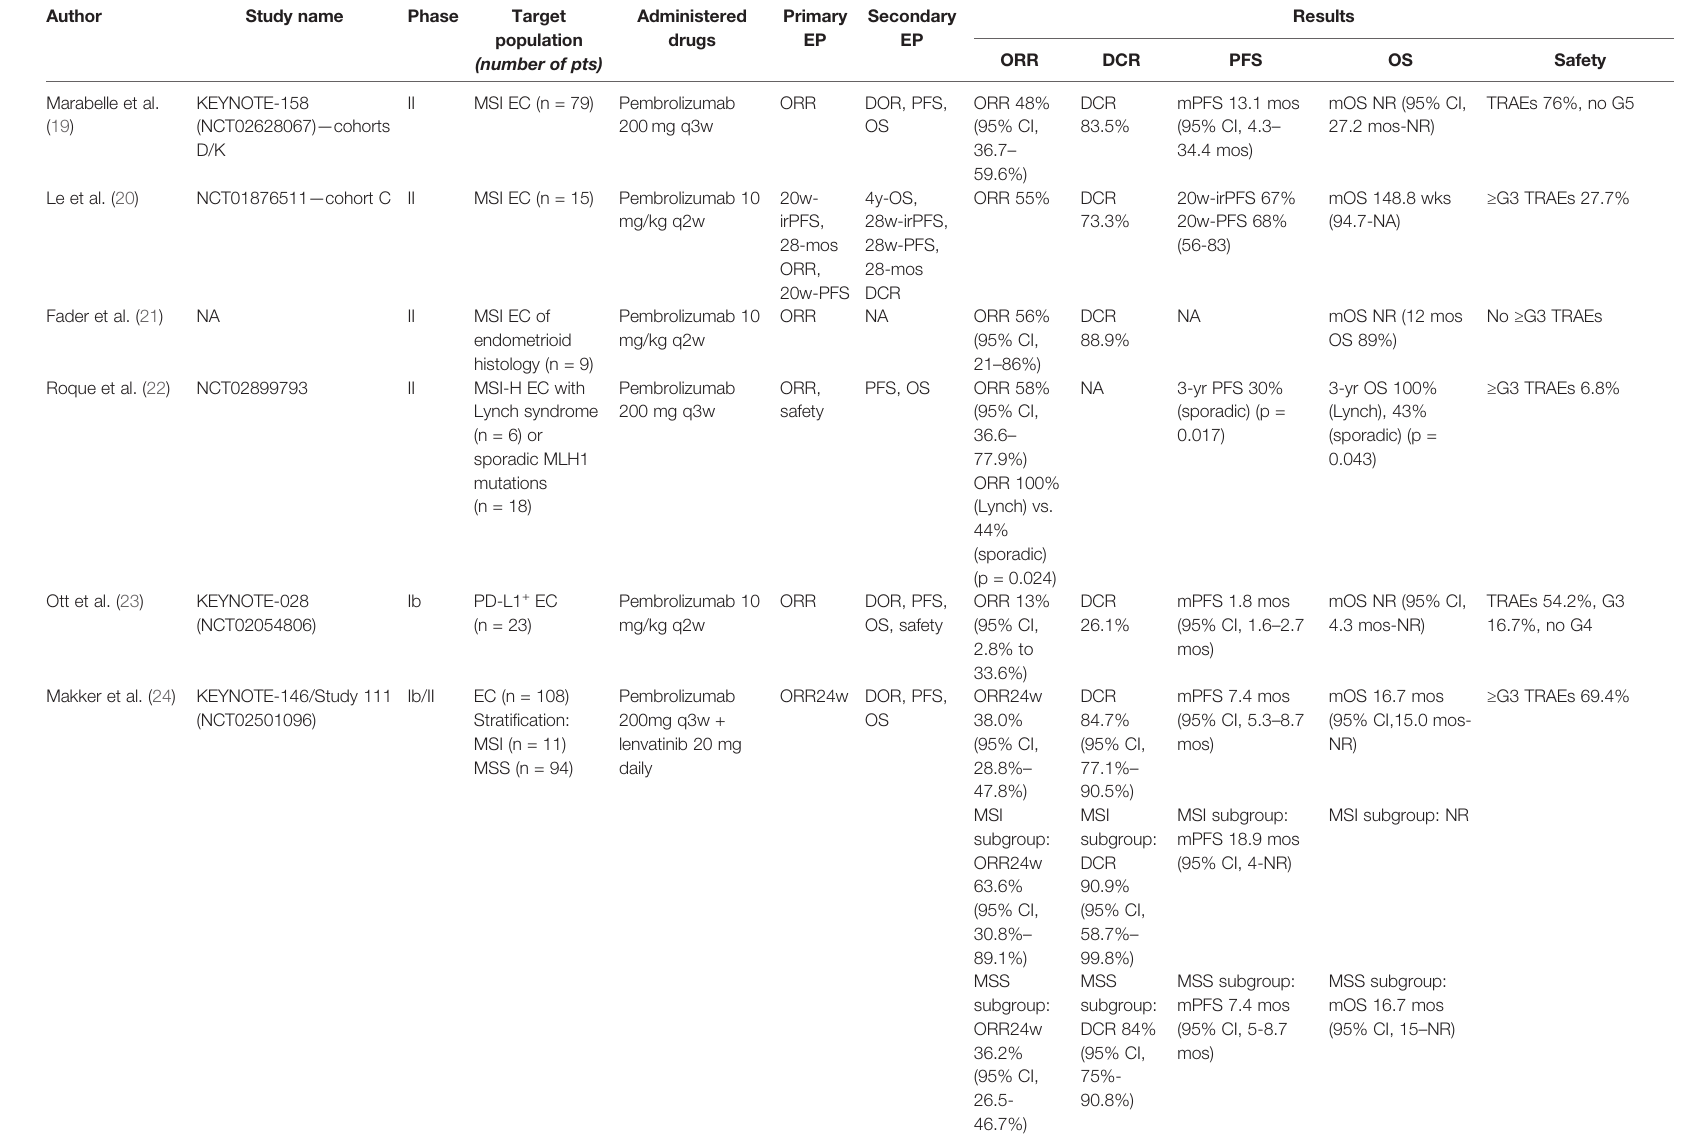
TABLE 1 | Trials of ICIs in advanced/recurrent